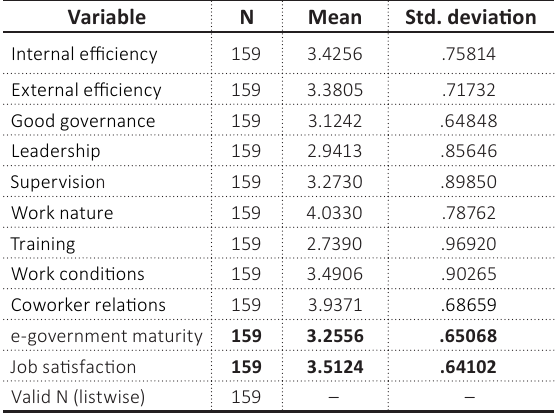
Table 1. Means and standard deviations of